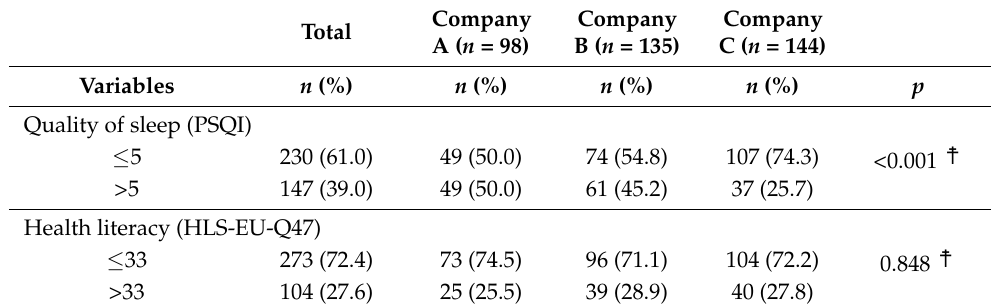
Among seven scales, two scales (quality of sleep and HL) have cutoff points. On PSQI, 39.0% have sleep disorders with a score of 6 or higher, and on HLS-EL-Q47, 72.4% showed low HL with a score of 33 or lower. Company C showed the lowest sleep disorder rate among the three companies ( p < 0.001). Regarding HL, no significant differences were observed among the three companies (Table 3). Table 3. Comparison of health literacy levels and sleep disorders among three companies.